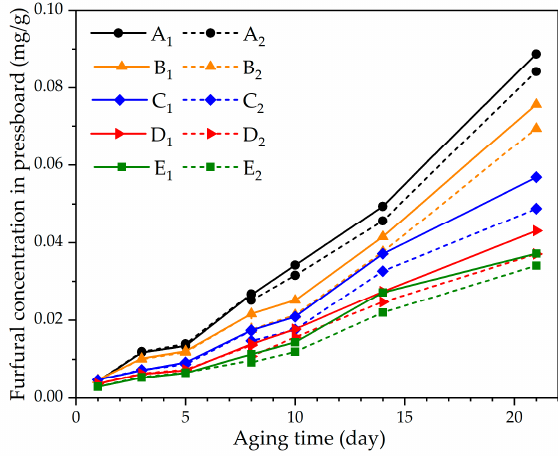
Figure 5. The relationship between furfural concentration in pressboard and aging time.